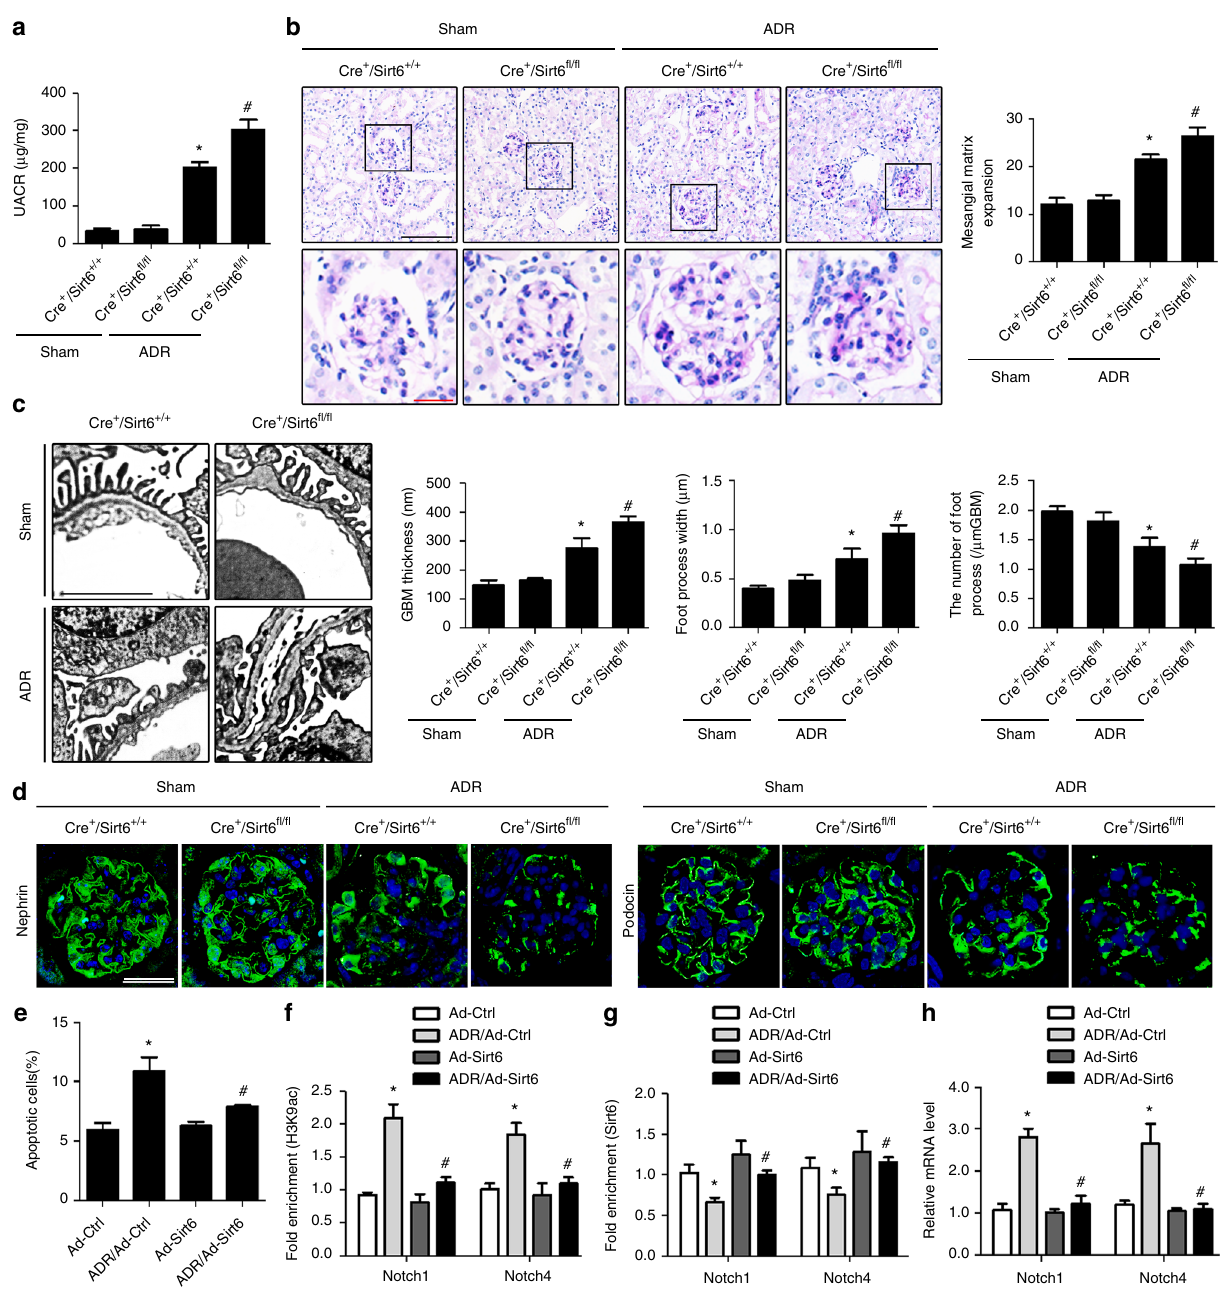
Fig. 8 ADR-treated Podocin- Cre Sirt6 fl / fl mice exhibites substantial podocyte injury and glomerulosclerosis. a UACR (urinary albumin-to-creatinine ratio) in different groups of mice. b Photomicrographs and quanti fi cations showing typical changes in glomerular structure in different groups of mice. Scale bar : black 100 μ m, red 25 μ m. c Representative photomicrographs and quanti fi cations of mean glomerular basement membrane (GBM) thickness, mean foot process width, and the number of foot processes in different groups of mice. Scale bar , 3 μ m. d Representative confocal microscopic images showing the expressions of nephrin and podocin in podocytes of the kidney from different groups of mice. Scale bar , 25 μ m. Podocyte-speci fi c Sirt6 knockout mice: 0.05 vs. Cre + /Sirt6 + / + ADR mice. ( n = 8.) e Podocytes with different treatments were stained with fl uorescein isothiocyanate (FITC)-conjugated